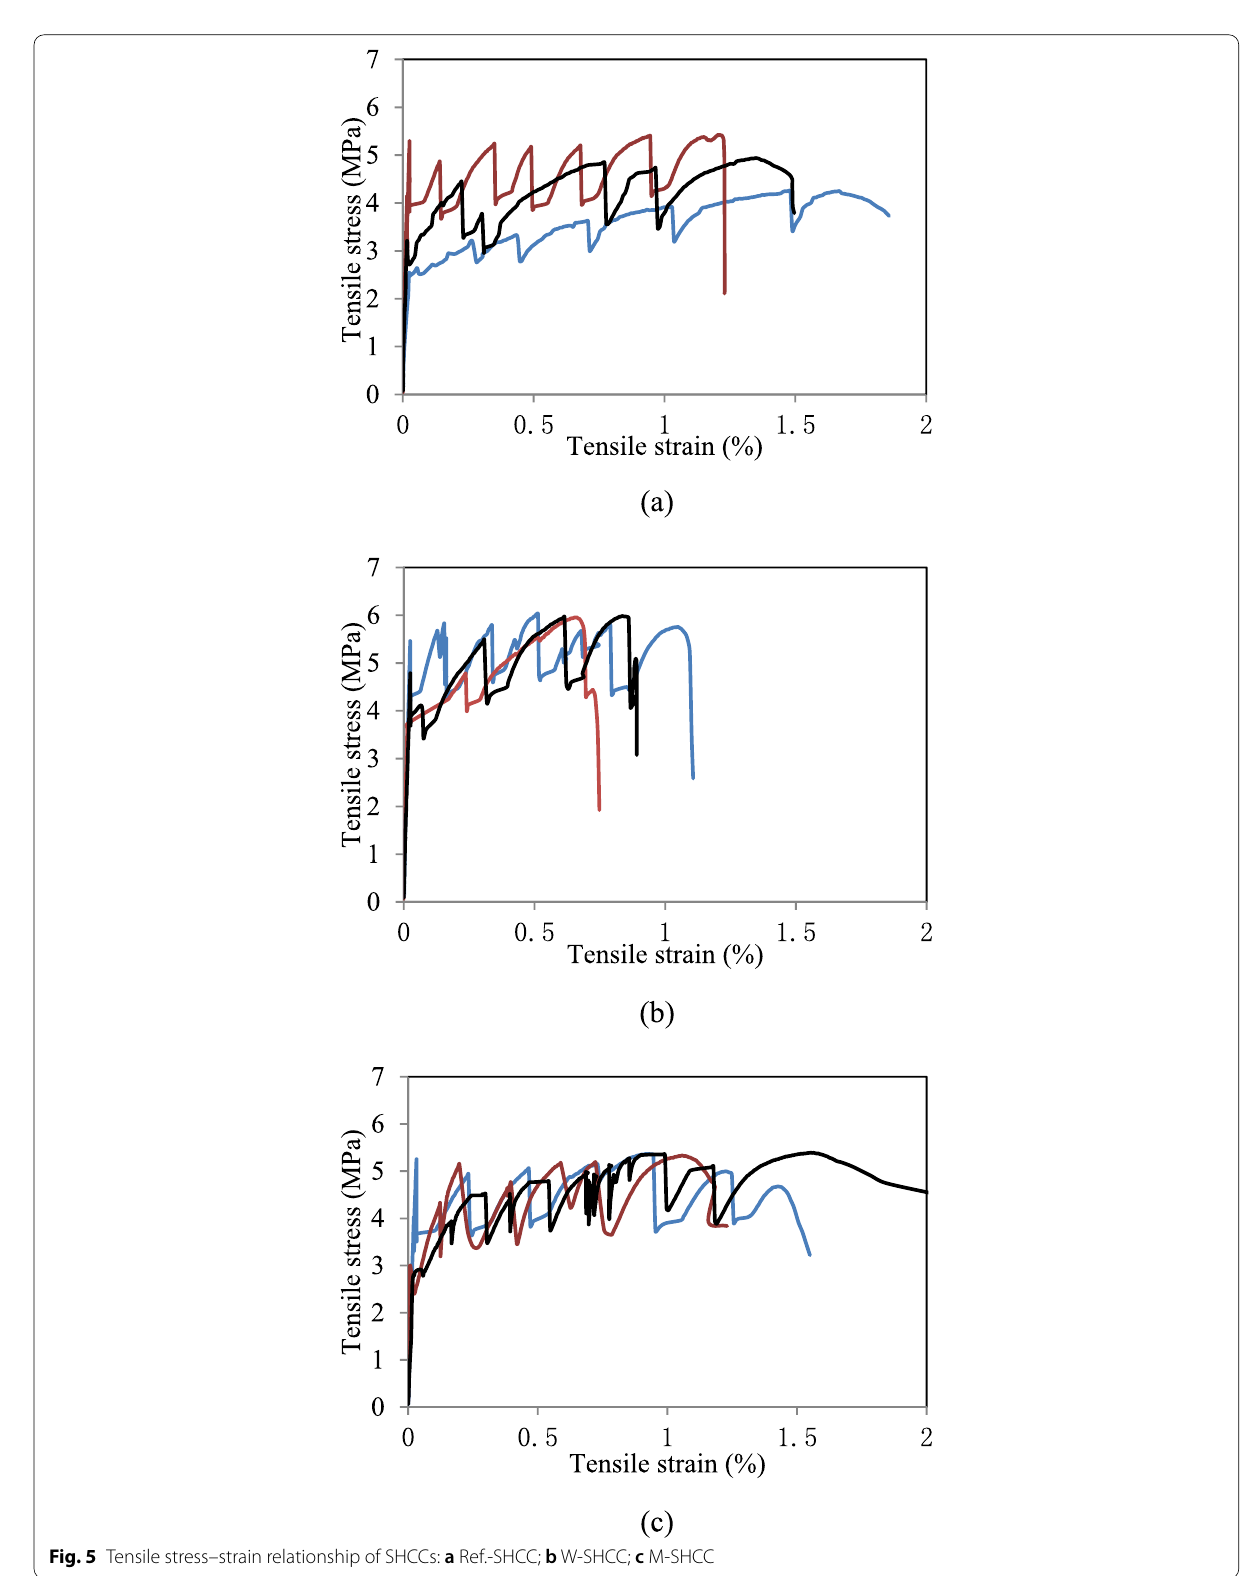
Fig. 5 Tensile stress–strain relationship of SHCCs: a Ref.-SHCC; b W-SHCC; c